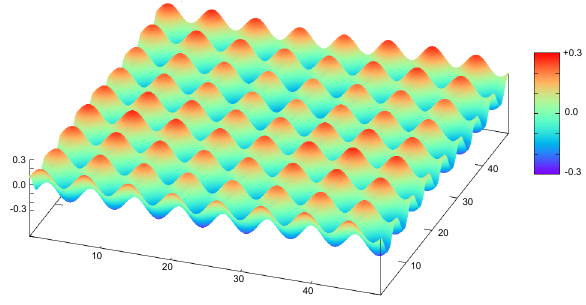
Figure 4. Model setup, showing cross-sectional domain and sinu- soidal topography variation from the top of the model ( z = 20) for each